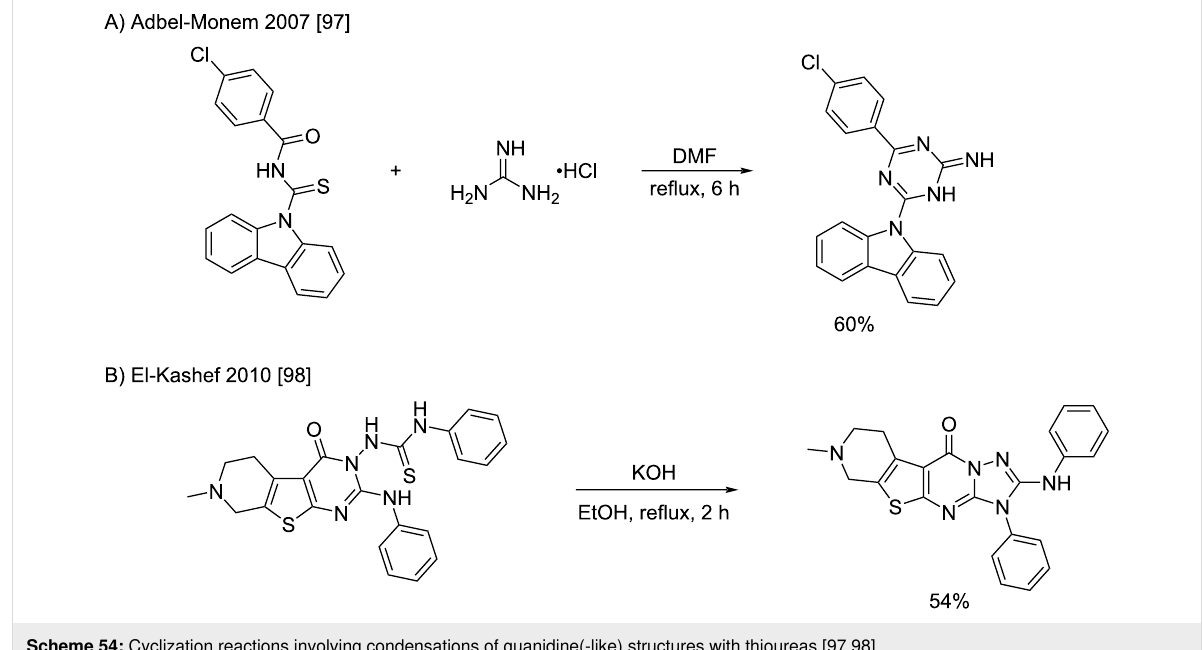
Scheme 54: Cyclization reactions involving condensations of guanidine(-like) structures with thioureas [97,98].